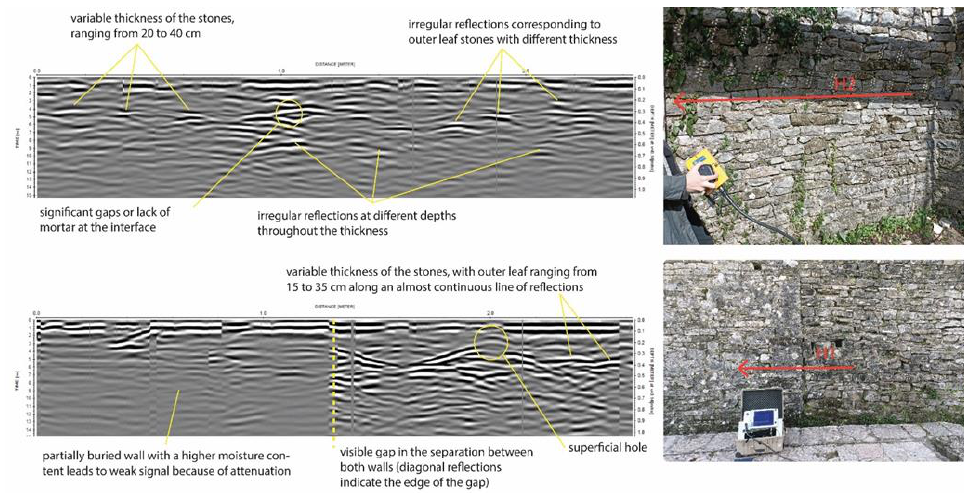
Figure 14. Horizontal GPR scans carried out at different locations in one of the tower walls.